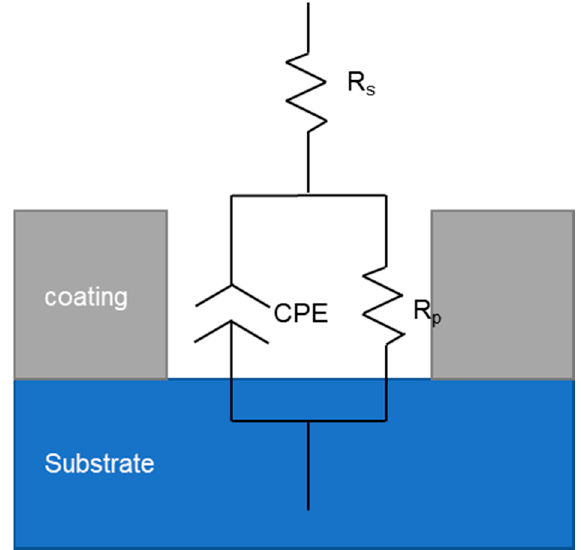
Figure 10. Equivalent circuit diagram.